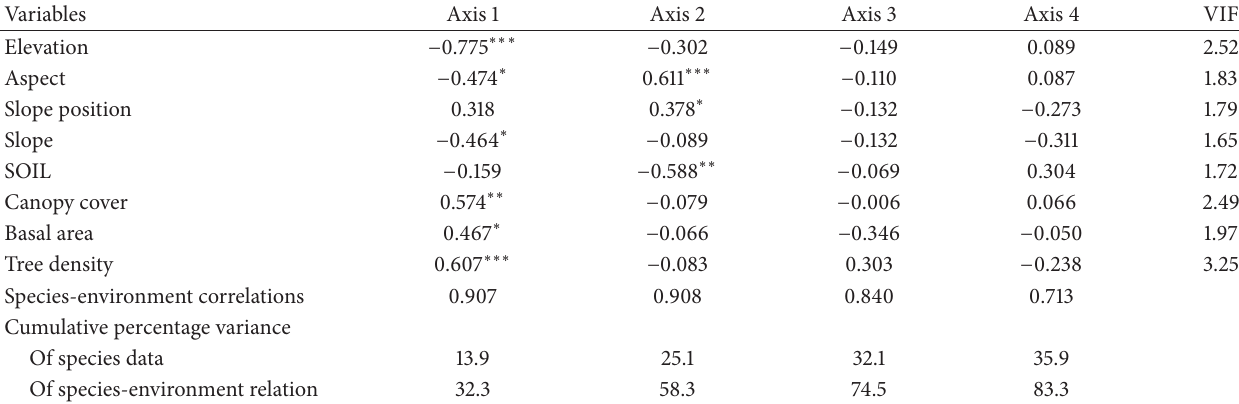
Table 3: Results of the CCA showed correlation coefficients between environmental variables and the CCA axes, species-environment correlation, cumulative variance relationship with the four axes, and variance inflation factor of each environmental variable (VIF).